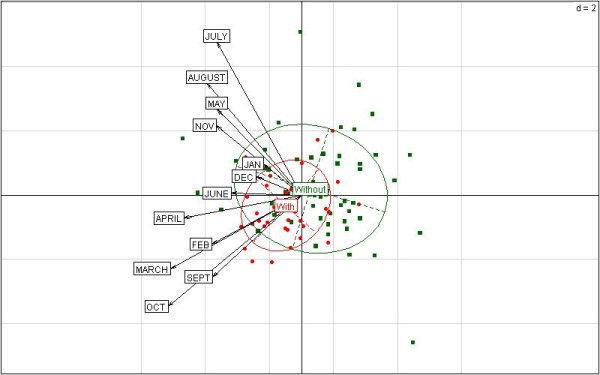
Principal Component Analysis for monthly mean temperatures, with the binary epidemic factor as supplementary variable. For November and December, the mean temperatures of the previous years were used. On the one hand, the horizontal axis, accounting for 17% of the total variance, gives a temperature gradient. Hence, the more a year is situated on the left, the warmer it is globally. On the other hand, the vertical axis, accounting for 13% of the total variance, permits to identify the years with warm intermediate seasons (situated at the bottom of the graphic). Years with and without epidemic are indicated with red circles and green squares, respectively. Thus epidemics were observed in years that were generally warmer, especially for intermediate seasons. Moreover, years with epidemic seem to keep a consistent profile with respect to monthly temperatures, since the associated ellipse is smaller.